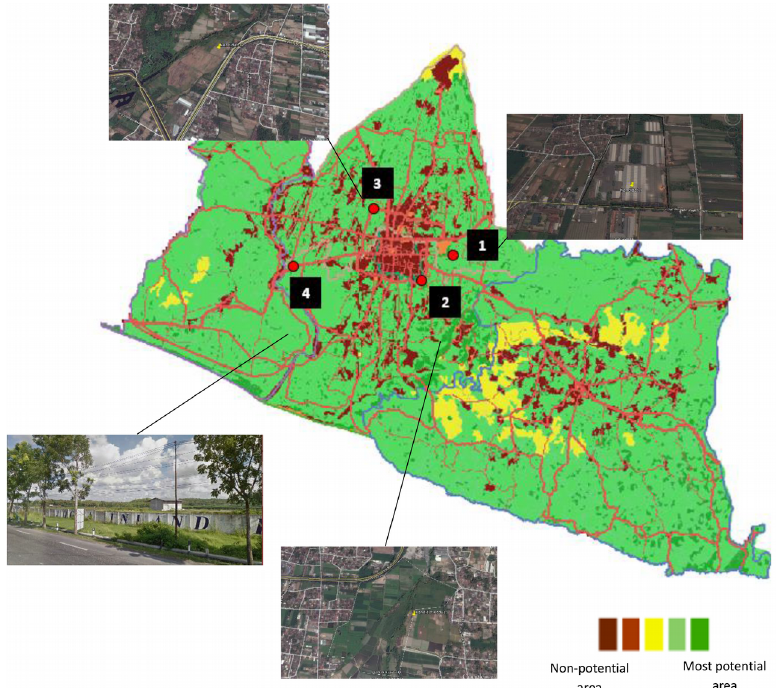
Table 3. Geometric mean and weights of determinants factors for potential areas for UDC